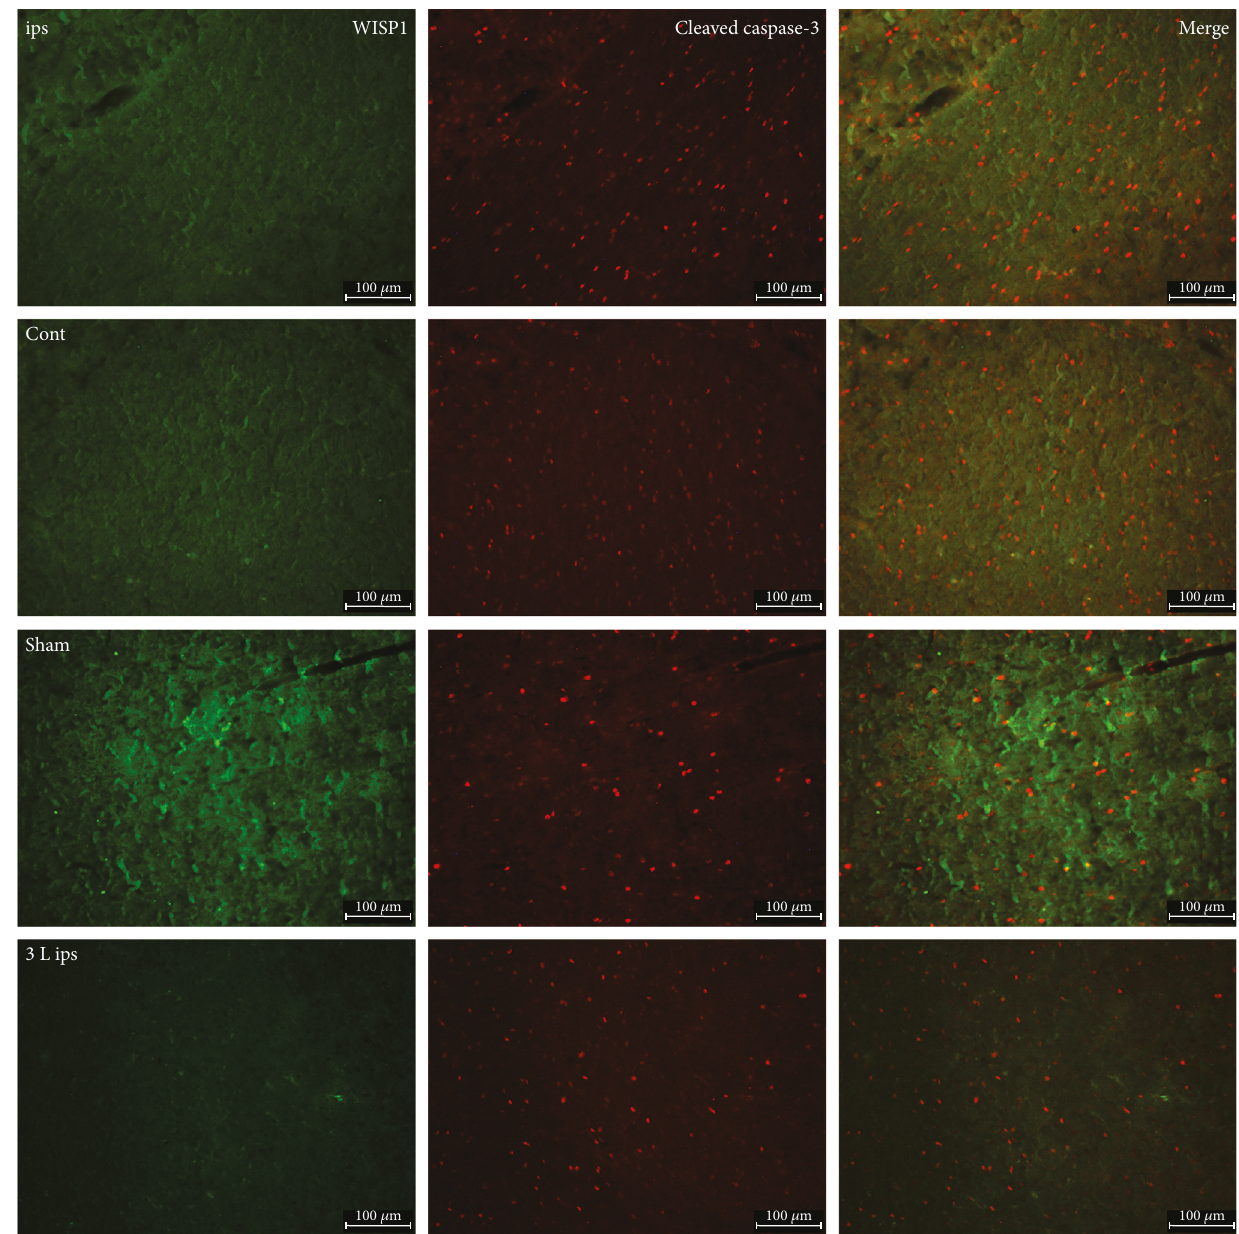
Figure 6: Double-labeling immuno fl uorescence of WISP1 and cleaved caspase-3 at 3d after TBI. Green: WISP1; red: cleaved caspase-3; cont: the control of ipsilateral 3d post-TBI group; ips: ipsilateral 3d post-TBI group; sham: sham group; 3 L ips: 3d post-TBI+ 1mM PQQ group; cont: the control of ipsilateral 3d post-TBI+1 mM PQQ group. Bar =100 μ